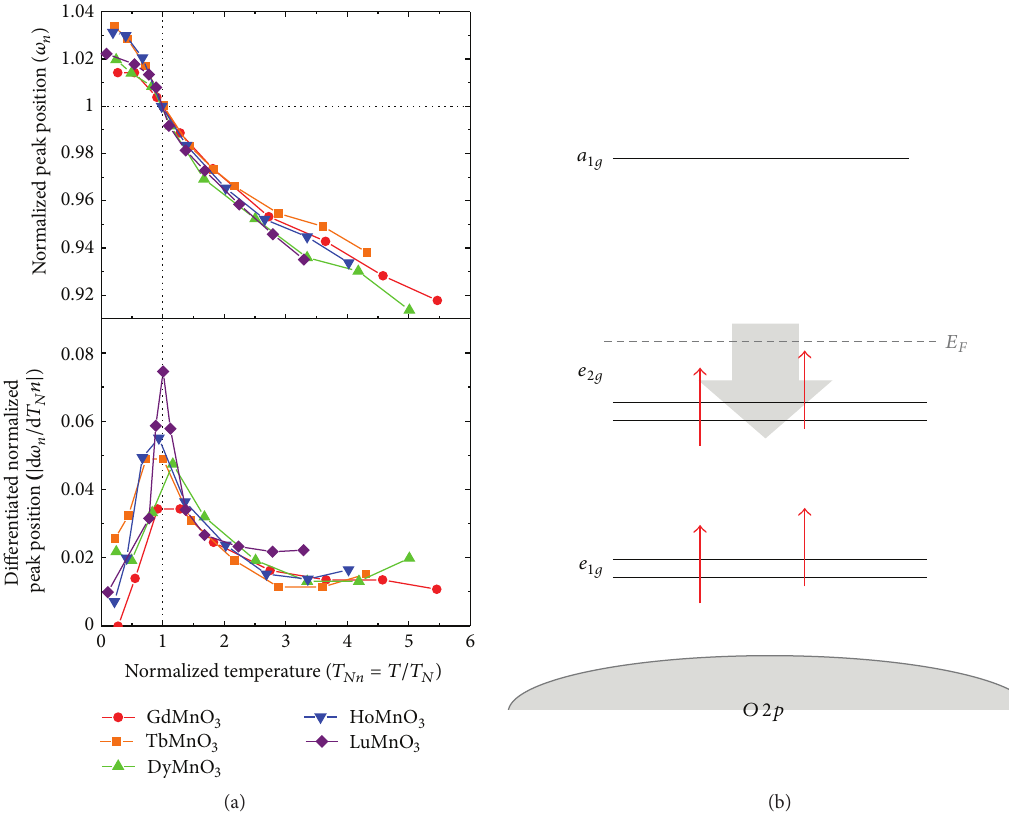
Figure 4: (a) Upper panel: temperature dependence of the peak positions normalized to the peak position at 𝑇 𝑁 as a function of the normalized temperature 𝑇 𝑁𝑛 ( ≡ 𝑇/𝑇 𝑁 ). Lower panel: absolute value of normalized peak position differentiated to normalized temperature [32]. Reprinted figure with permission from Choi et al. [32]. Copyright (2008) by the American Physical Society. (b) Schematic diagram of the d-d transition in ReMnO 3 . The red arrows indicate electrons reside in the d orbitals, and the gray arrow indicates lowering of 𝑒 2𝑔 band caused by the temperature